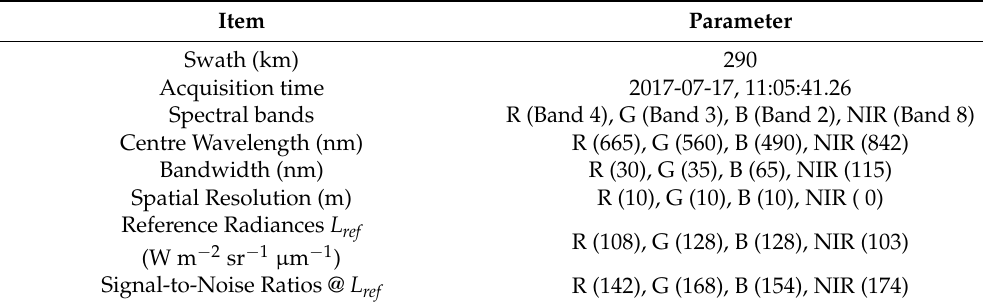
Table 2. Main imaging parameters of Sentinel-2A satellite.